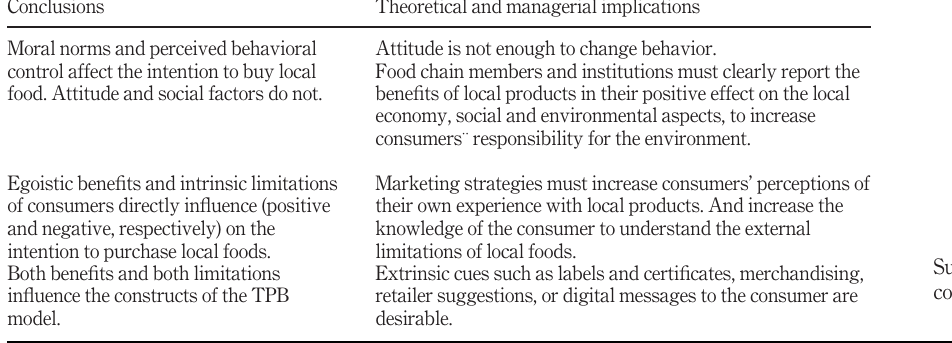
Table 5. Summary of